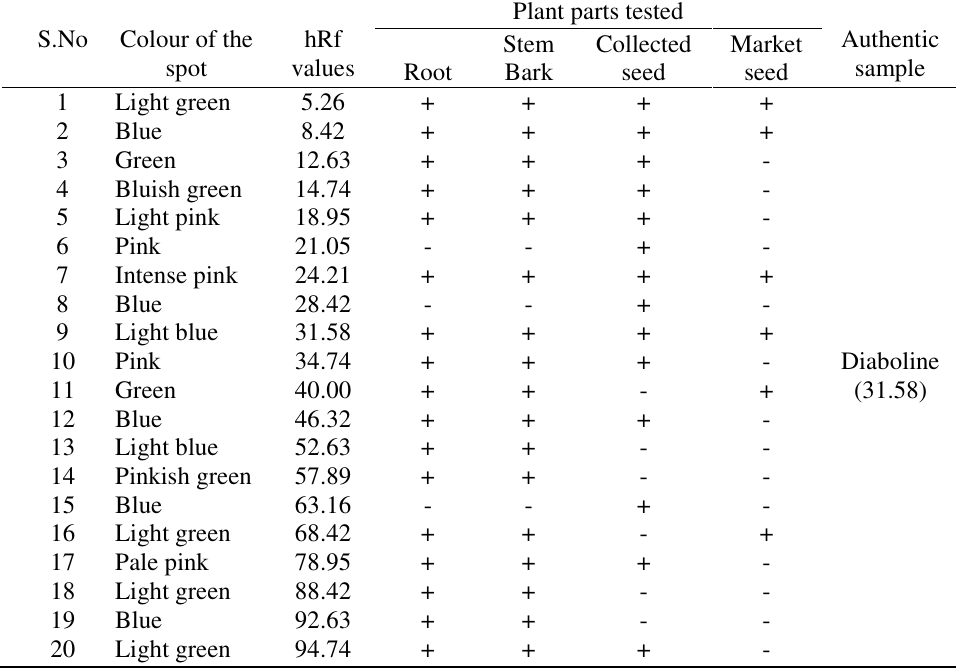
Table 3. Qualitative separation of Alkaloids S.potatorum by TLC(UV254nm) S.No Colour of